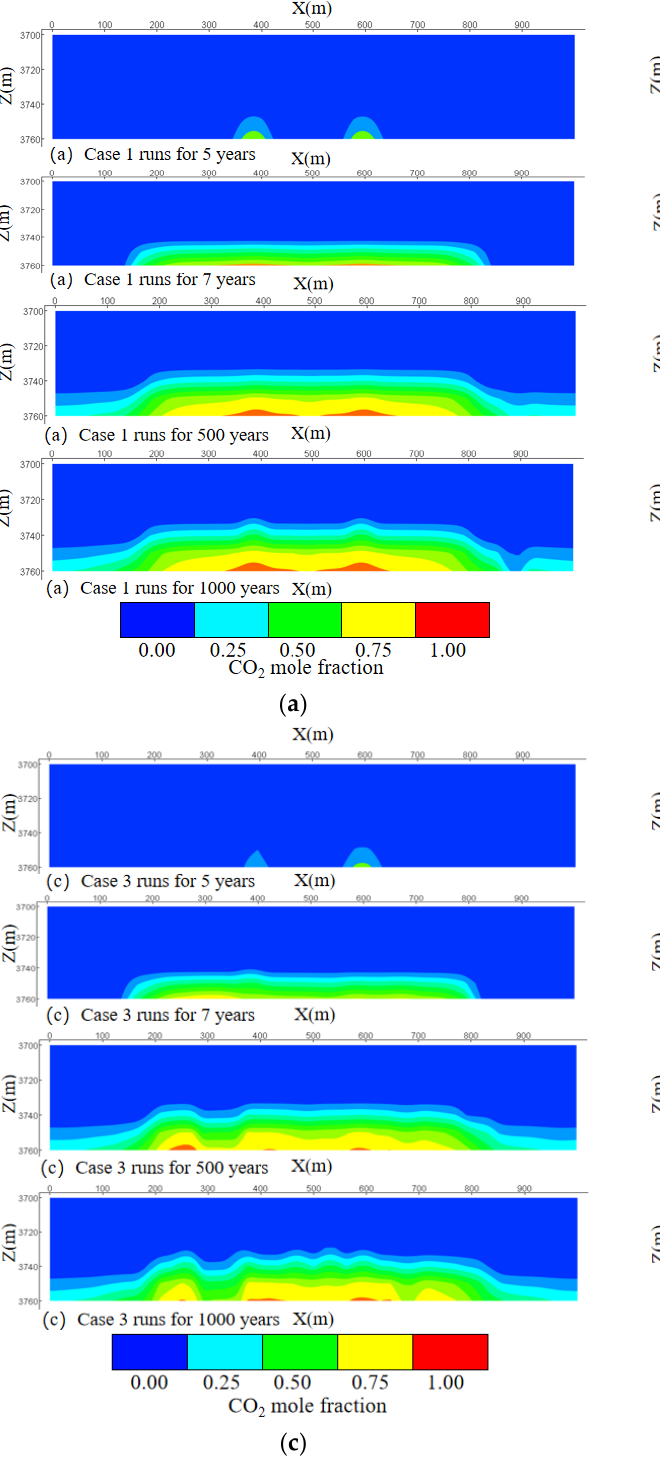
Figure 8. Profile of CO 2 mole fraction in caprock under four schemes at different times: ( a ) homoge- neous caprock model; ( b ) layered homogeneous caprock model; ( c ) heterogeneous caprock model; ( d ) layered heterogeneous caprock model.